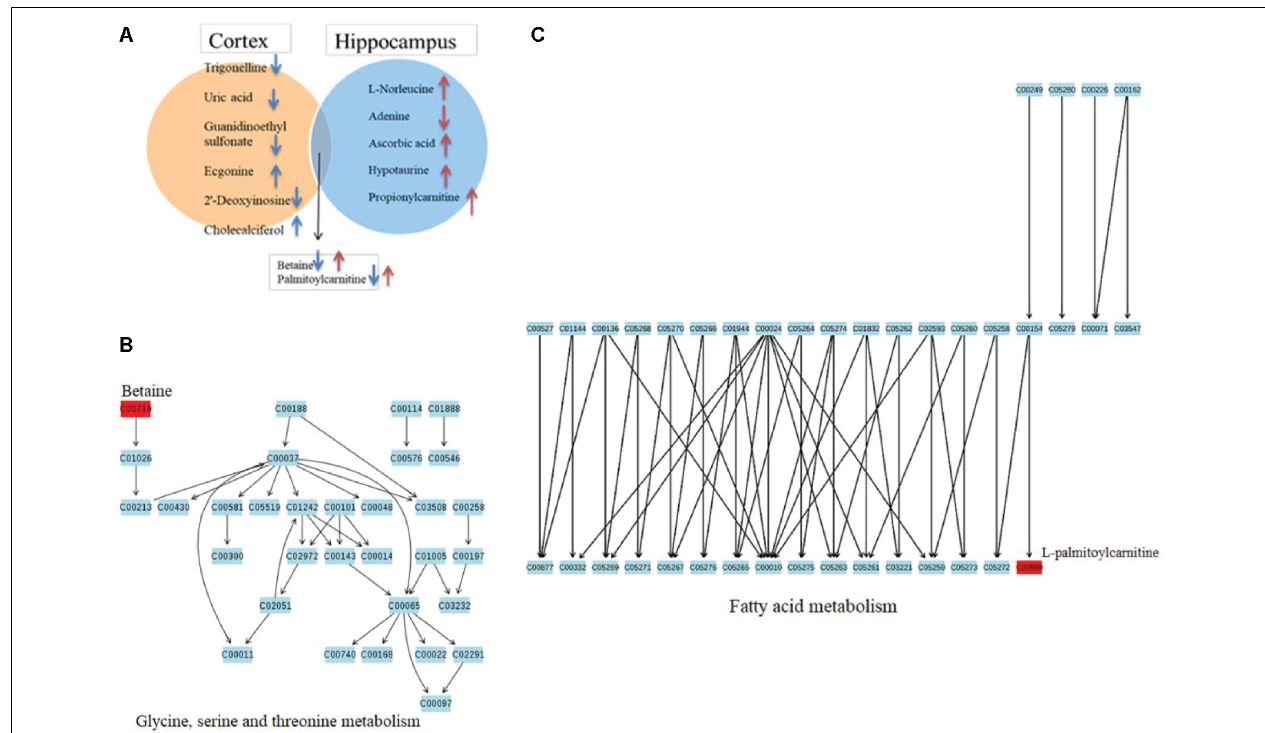
FIGURE 7 | Venn diagram describing the different VIP metabolites in two distinctive brain tissues after traumatic brain injury (TBI) on day 7. (A) A Venn diagram indicates the different metabolites corresponding to two brain tissues, showing with blue arrows the upregulated or downregulated cortical metabolites and red ones for those of the hippocampus. The overlap display shows that the two metabolites are both in response to subacute TBI in the two brain tissues, with different trends. (B) Pathway topology analysis associated with betaine in glycine, serine, and threonine metabolism was carried out by a metaboanalyst. (C) Pathway topology analysis associated with palmitoylcarnitine in fatty acid metabolism was carried out by a